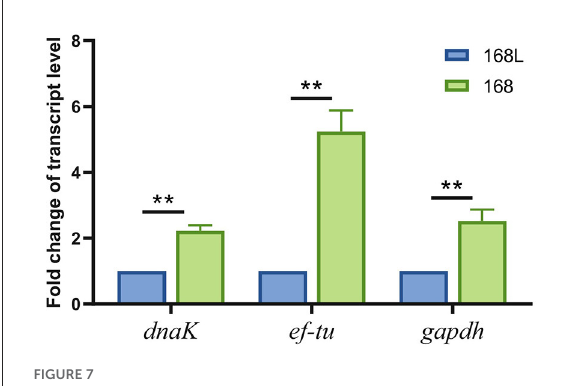
FIGURE7 Transcription levels of dnak , ef-tu , and gapdh genes between high virulence M. hyopneumoniae strain 168 and low virulence strain